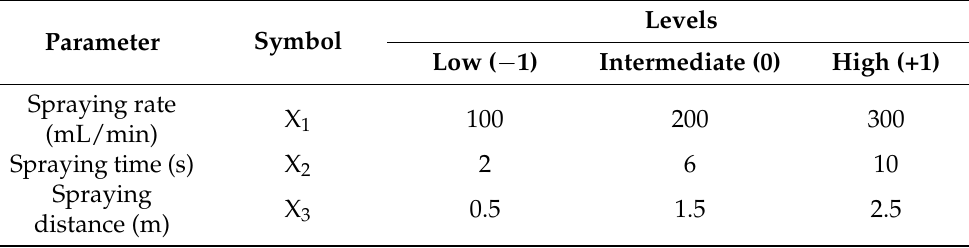
Table 1. Box–Behnken design matrix parameters and levels used to assess slightly acidic electrolyzed water spraying disinfection